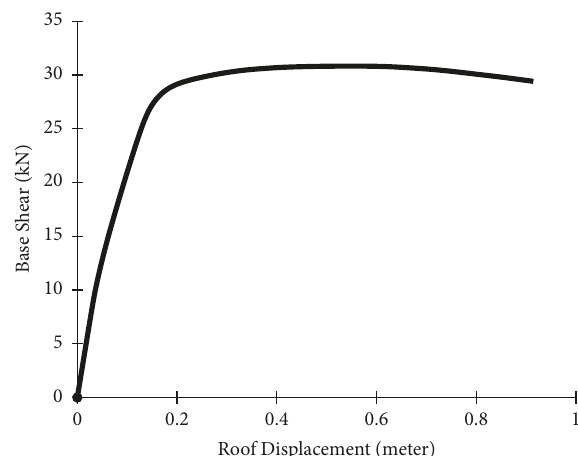
Figure 15: Unbraced portal frame pushover curve.